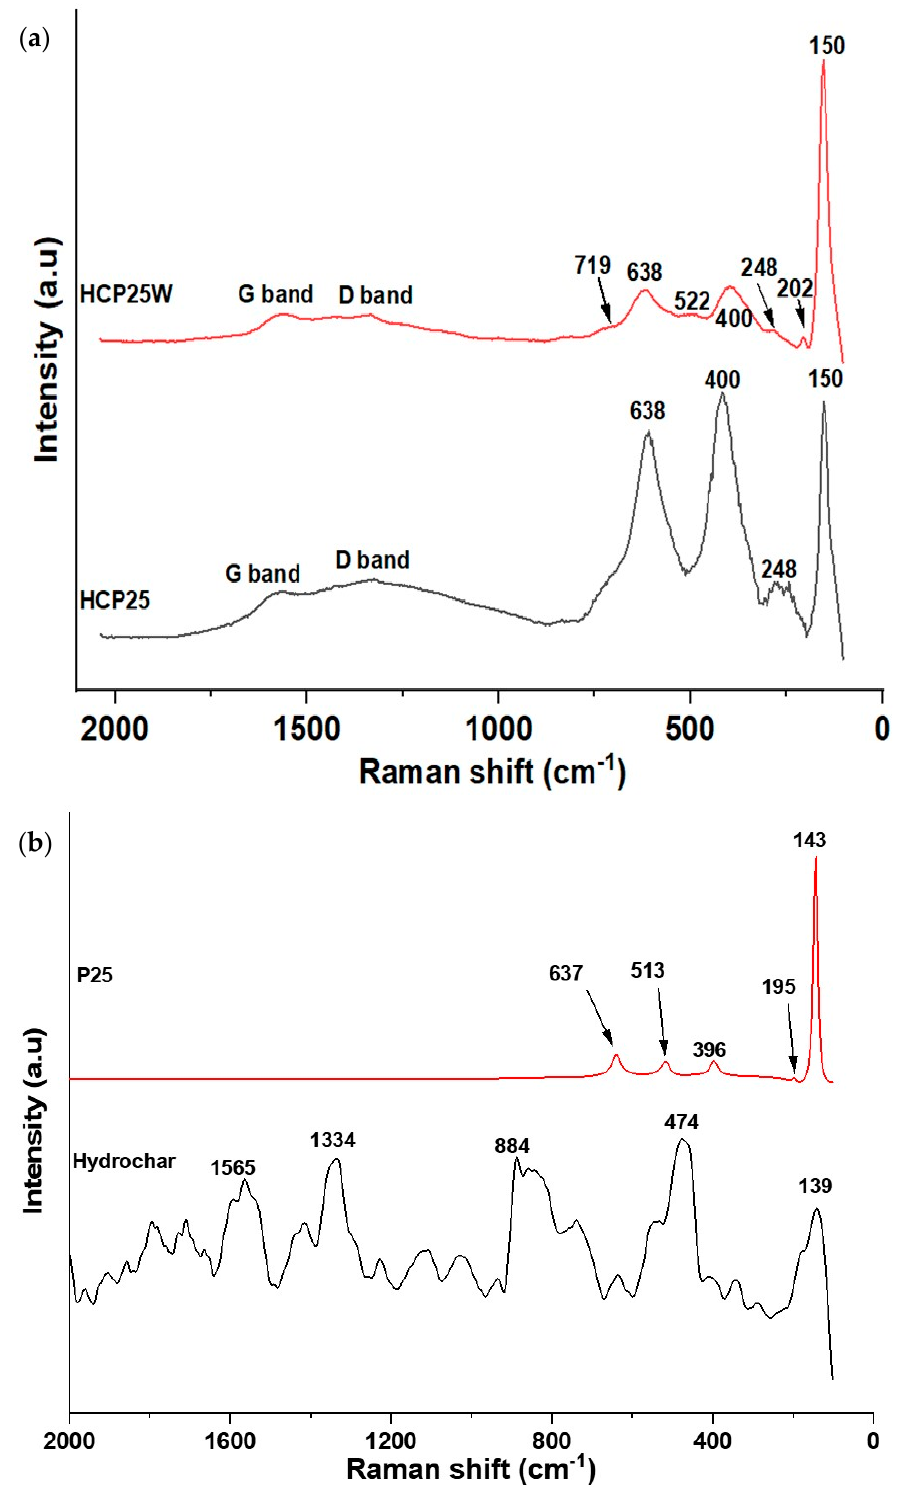
Figure 2. ( a ) Raman spectra HCP25 and HCP25W and ( b ) Raman spectrum for P25 and hydrochar. The spectra of P25 and hydrochar are given with different y-axis scale.